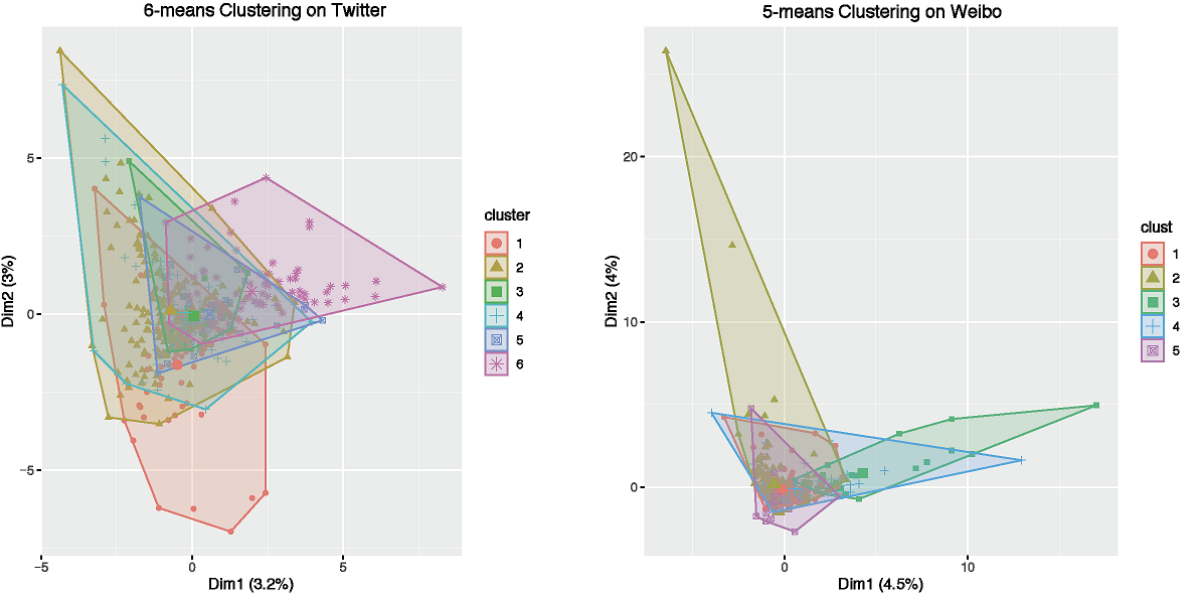
Figure 6. k -means clustering on viral tweets (left) and Weibo posts